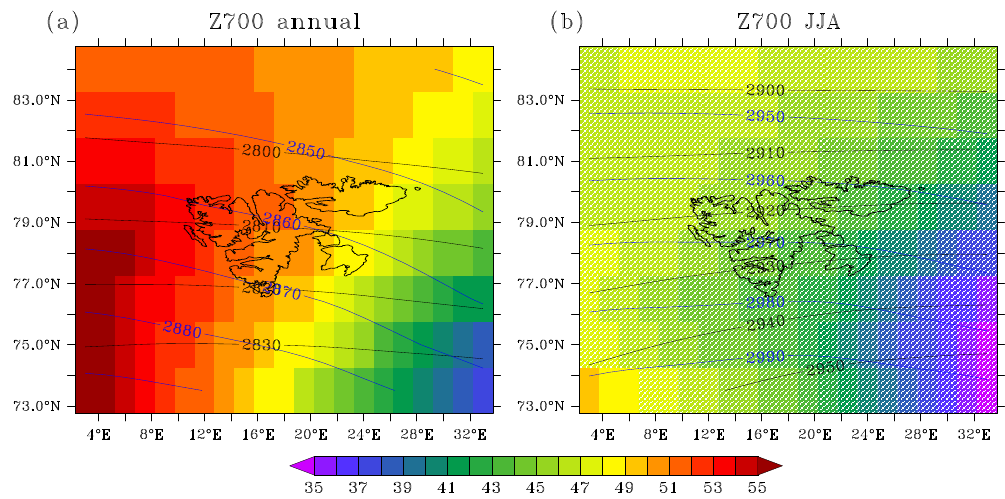
Figure 9. (a) Difference of mean annual geopotential height (m) at 700hPa (Z700) between MIROC5 and ERA-Interim over 1980–2005. The black lines show Z700 for ERA-Interim and the blue lines are for MIROC5. (b) Same as (a) but in summer (JJA). The non-hatched areas correspond to the areas for which the difference is significant at the 95% confidence level (with respect to the ERA-Interim-based 1980–2005 interannual variability), whereas the hatched areas corresponds to non-significant differences.